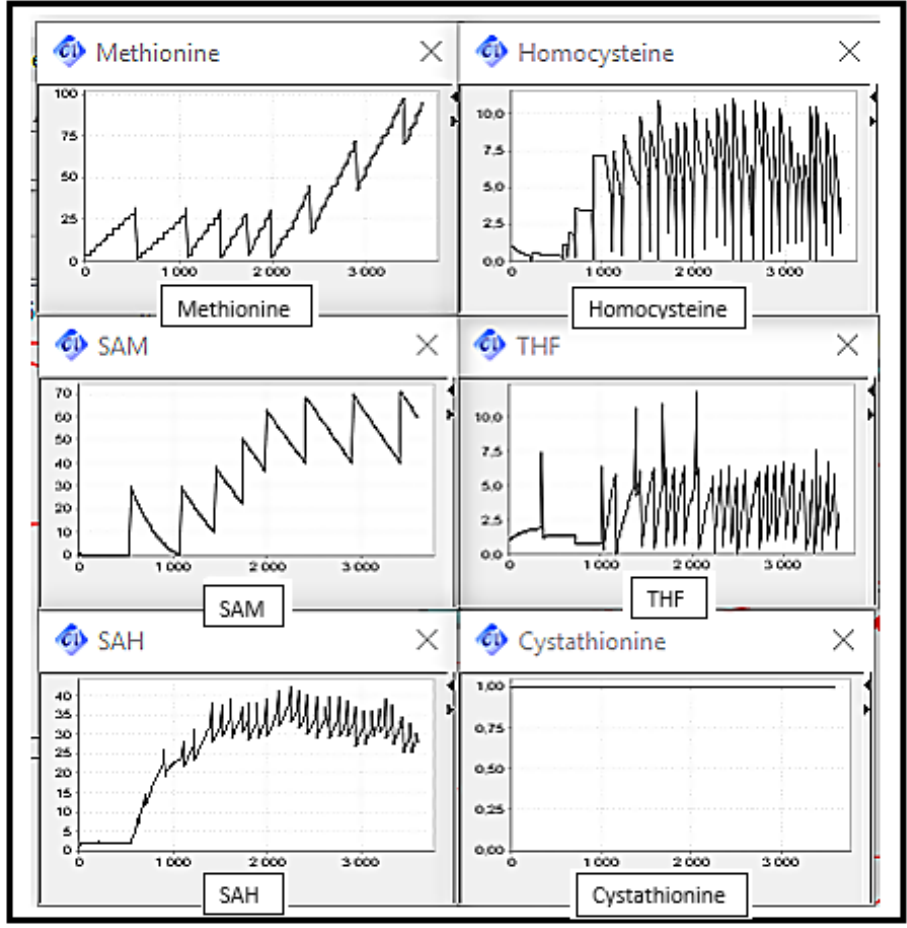
Figure 11. Simulation of the HFPN model representing the studied metabolic pathway in case of BHSM and CBS Deficiencies (Scenario